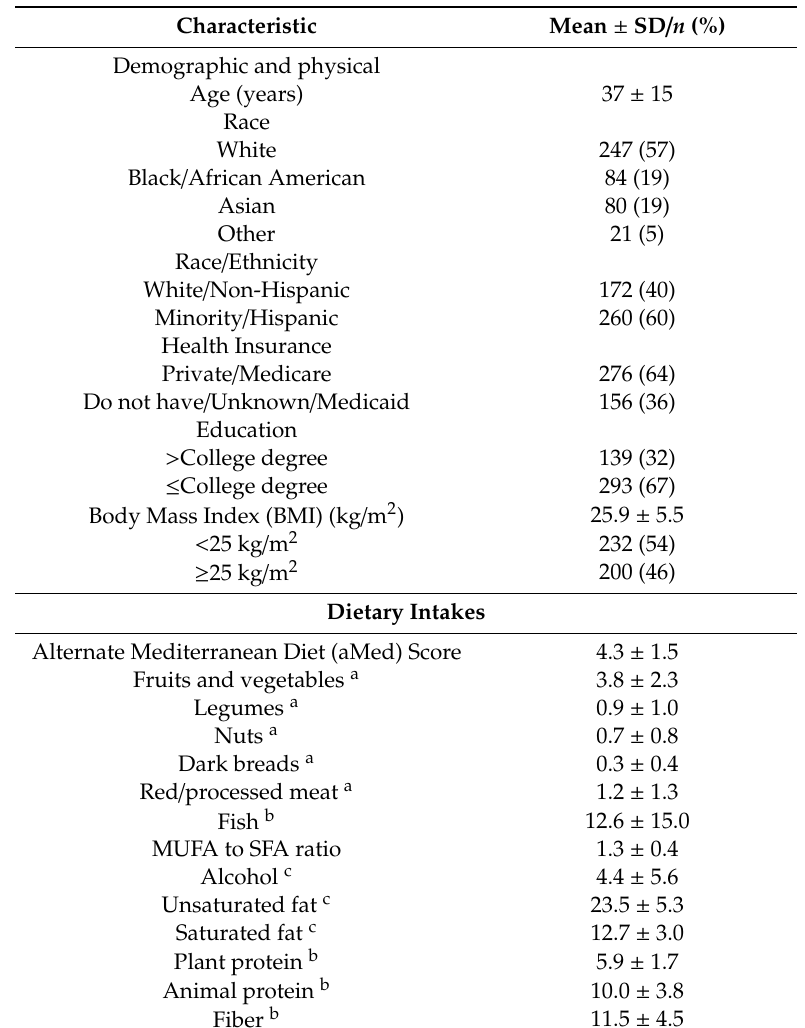
Table 1. Descriptive characteristics of the analytic sample at baseline ( n = 432).